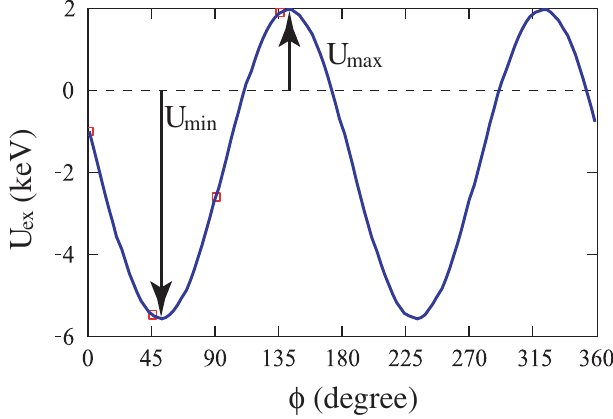
FIG. 5. (Color) Behavior of particle energy exchange with the 465 MHz dipole mode ( B max ¼ 0 : 001 T ) versus of the input phase. The particles are accelerated from 2 to 6.33 MeV by the E 010